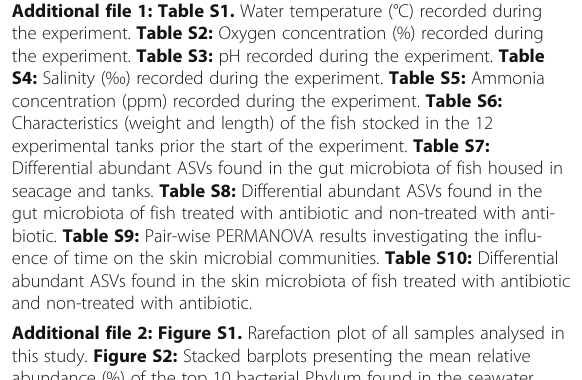
the experiment. Table S3: pH recorded during the experiment. Table S4: Salinity ( ‰ ) recorded during the experiment. Table S5: Ammonia concentration (ppm) recorded during the experiment. Table S6: Characteristics (weight and length) of the fish stocked in the 12 experimental tanks prior the start of the experiment. Table S7: Differential abundant ASVs found in the gut microbiota of fish housed in seacage and tanks. Table S8: Differential abundant ASVs found in the gut microbiota of fish treated with antibiotic and non-treated with anti- biotic. Table S9: Pair-wise PERMANOVA results investigating the influ- ence of time on the skin microbial communities. Table S10: Differential abundant ASVs found in the skin microbiota of fish treated with antibiotic and non-treated with antibiotic. Additional file 2: Figure S1. Rarefaction plot of all samples analysed in this study. Figure S2: Stacked barplots presenting the mean relative abundance (%) of the top 10 bacterial Phylum found in the seawater (SW) and on the skin of fish, comparing fish housed in seacages and those relocated and acclimatised in tanks. Figure S3: Means plots showing the change in mean value of Pielou ’ s evenness (a) and Faith ’ s phylogenetic diversity (b) in the gut bacterial communities, over the 18- day treatment period (from n = 4 fish). Figure S4: PCoA plot represent- ing Bray-Curtis similarities comparing the change in global skin bacterial assemblages after treatment with antibiotics (+) over 18-days, with those fish that did not receive treatment ( − ). Figure S5: Means plots showing the change in mean value of Shannon ’ s index of diversity (a), Pielou ’ s evenness (b), total observed ASVs (as a measure of richness) (c) and Faith ’ s phylogenetic diversity (d) in the skin bacterial communities, over the 18-day treatment period (from n = 4 fish). Figure S6: Venn diagram showing the distribution of unique and shared ASVs in the seawater, and the DNA and RNA inoculum samples. The total number of ASVs within each group are denoted in parentheses. Figure S7: Mean plot present- ing the mean number of observed ASVs for the different treatment groups; A − /FMT − , A + /FMT − , A − /FMT G , A + /FMT G , A − /FMT W and A + /FMT W over 15days post FMT (mean from n = 4